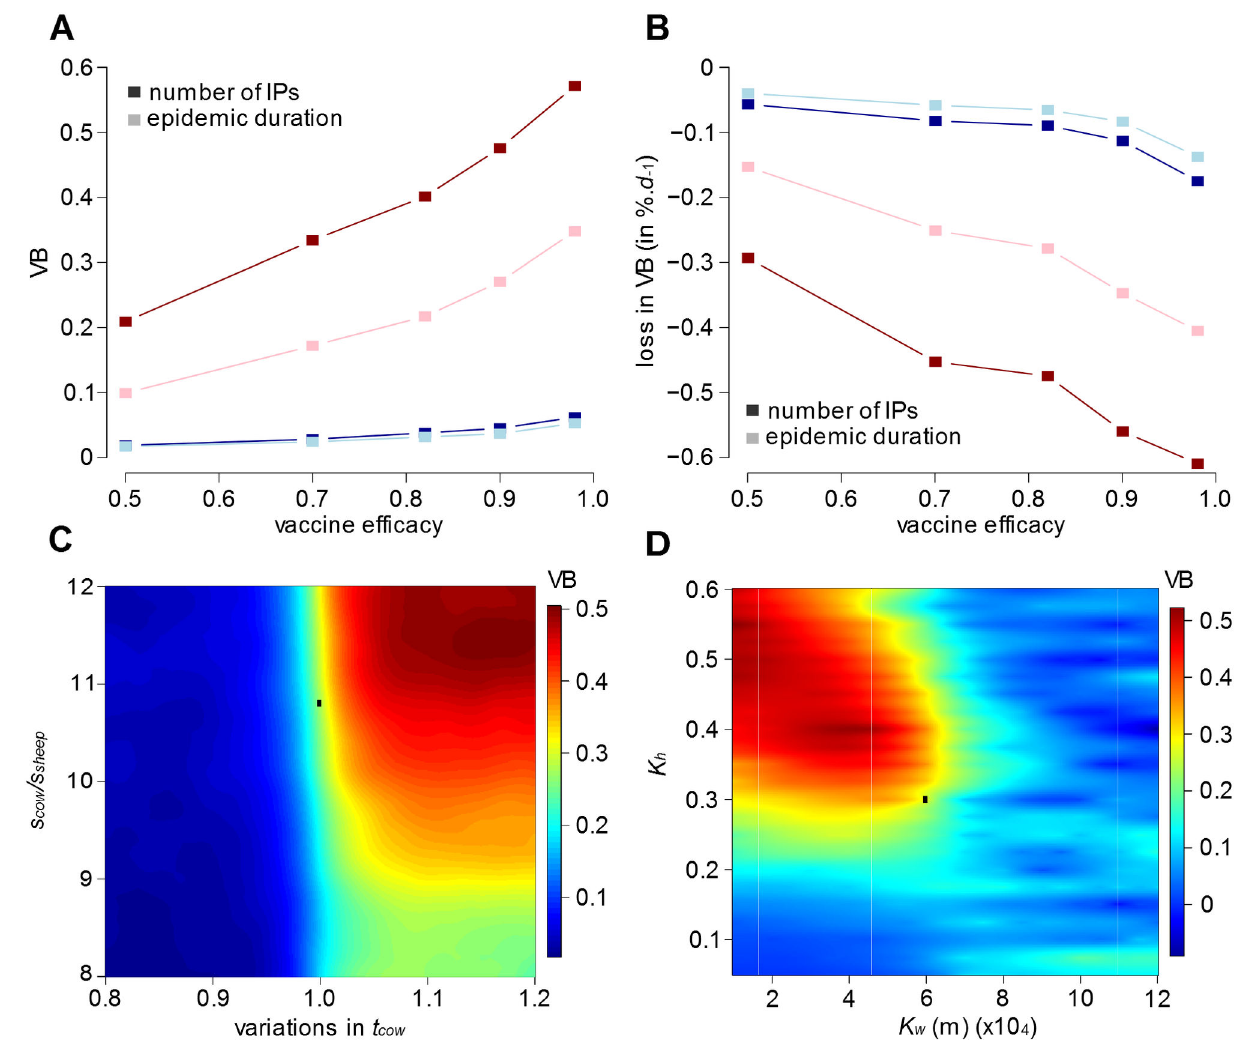
Figure 7. Sensitivity analysis on the benefit of the vaccination policy. Variations in vaccination benefit VB due to changes (A) in vaccine efficacy, (C) in susceptibility (s ) and infectiousness (t ) of cattle, (D) in the width (K ) and height (K ) of the cow cow w h transmission kernel function. (B) Variations in the loss of VB for each day increases in delaying its implementation in the field. A and B show evolution of the different measures for two counties: Aberdeenshire (red) and Ayrshire (blue) as examples for the different dynamics identified in Scotland (see Figure 5A for details). C and D show evolution of the different measures for Ayrshire as example of the dynamics observed in Scotland. Black rectangle in C and D marks values observed during the 2001 epidemic in Scotland. Simulations in A, C and D were generated considering vaccination policy focused on cattle and implemented at day 7 as a complement to the culling of IP/DC